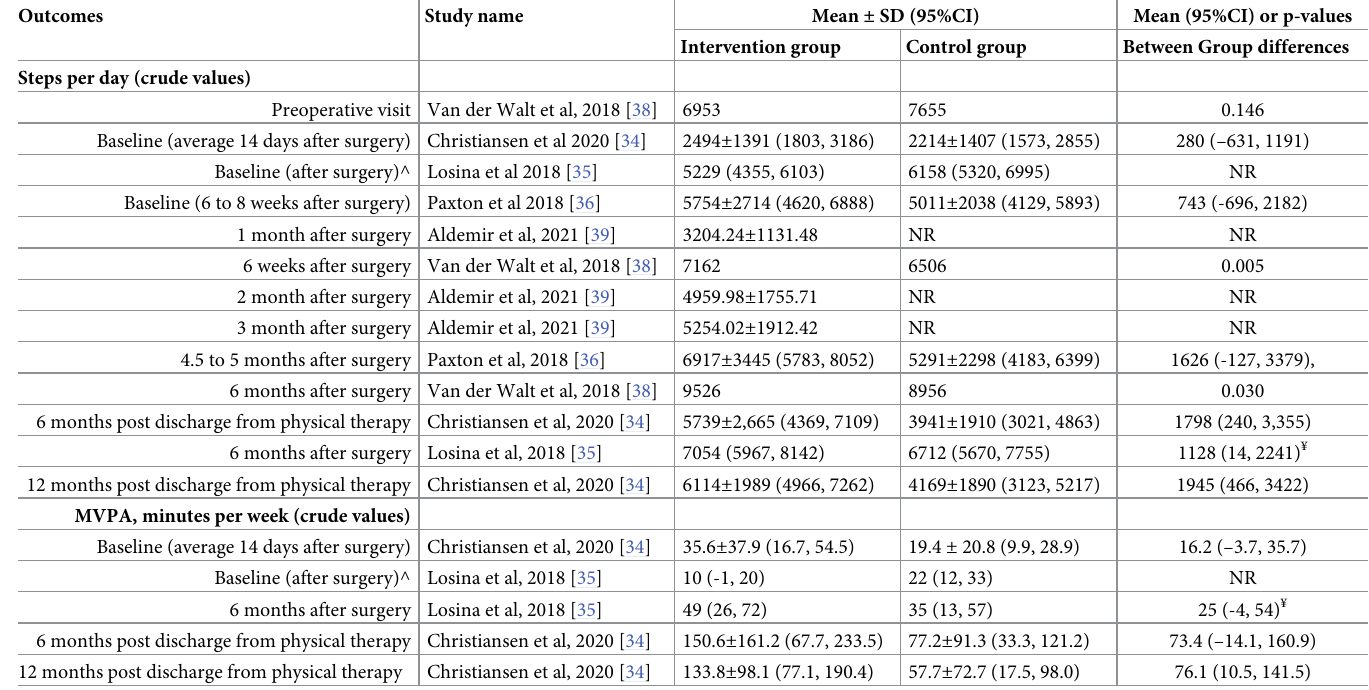
Table 3. Effects of physical activity interventions that use wearables on outcomes related to physical activity in adults after orthopaedic